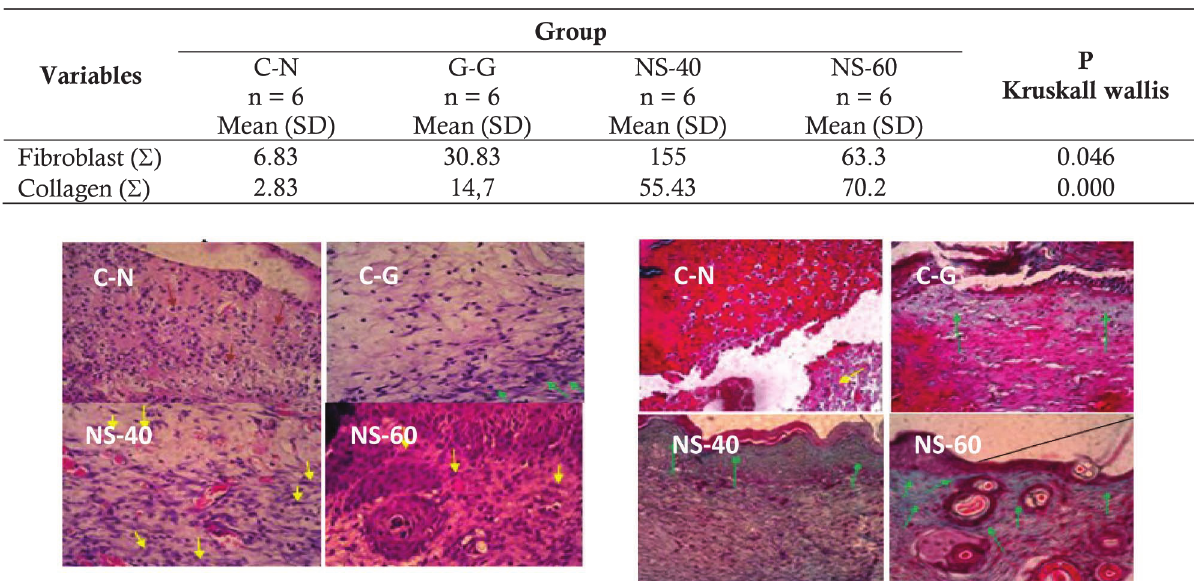
Figure 2. Figure 3.